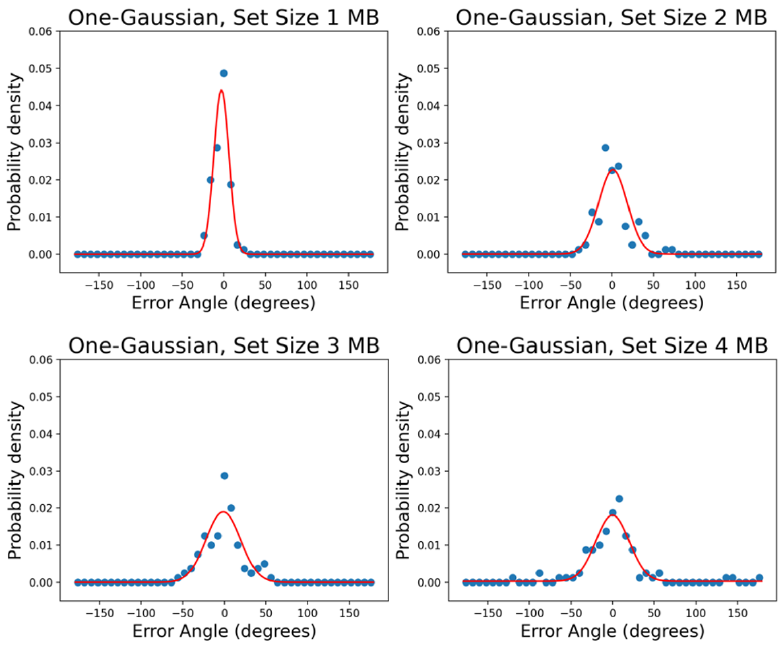
Figure 4. An example of the one Gaussian + uniform mixture model fits for the single report condition. The probability density is shown as a function of the error angle. The figures show the data from subject MB. The dots are the data with a bin size of 4 ◦ . The red solid curves are the probability density functions that were replotted from the cumulative distribution fitting.